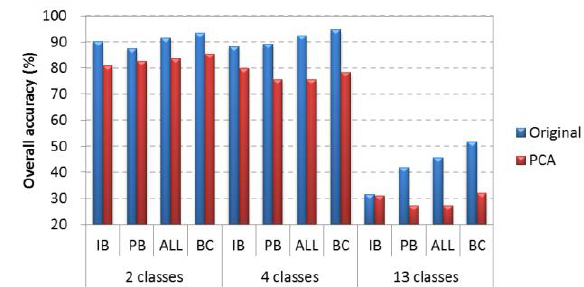
Figure 5. Tree species classifications using different features with principal component analysis